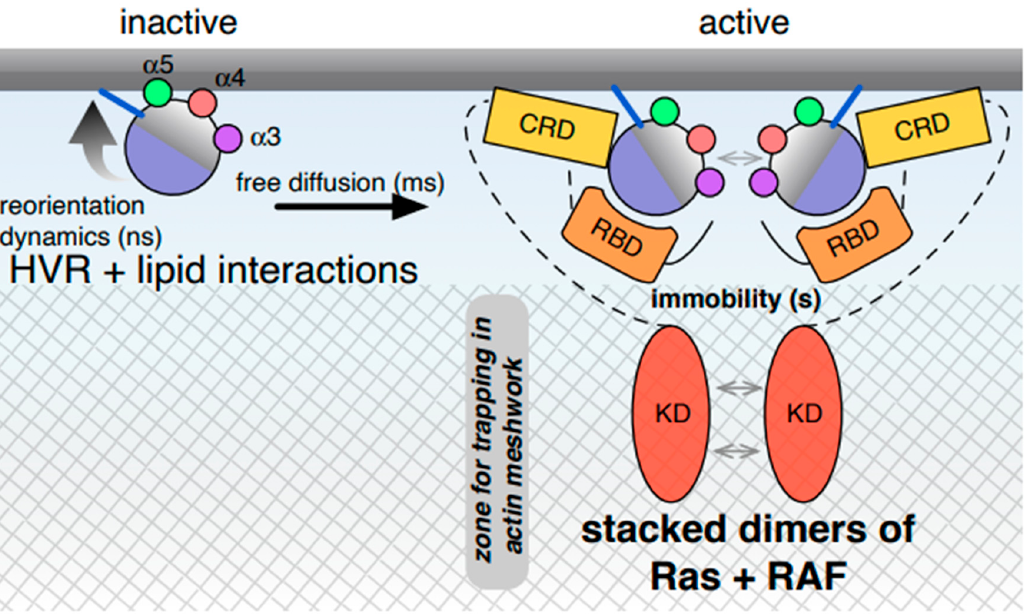
Figure 2. Ras dynamics on the membrane. Inactive Ras diffuses more freely than active Ras. Lateral segregation and stochastic clustering of Ras isoforms appears to be predominantly mediated by HVR interactions with membrane lipids. In living cells, diffusion can be somewhat hindered by the subcortical actin meshwork (cross hatched). Current data suggest that transient immobilization of active Ras occurs after engagement of binding partners, such as RAF effectors (domains in yellow to orange). Both increased molecular mass and enhanced trapping in the actin meshwork contribute to hindered diffusion. The minimal core of these immobile nanoclusters appears to be the dimers of Ras bound to dimers of RAF, with RAF proteins actually ‘scaffolding’ the Ras nanoclusters by enhancing